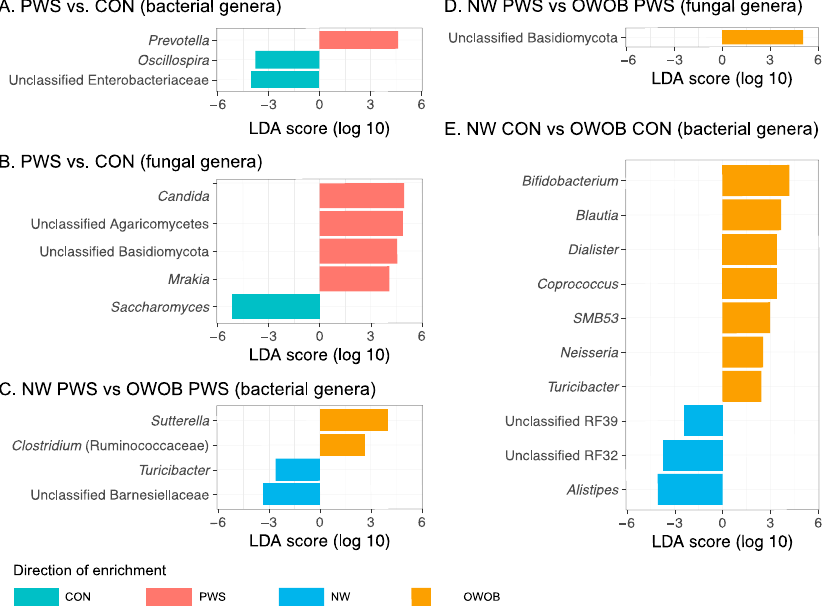
Figure 2. Discriminative features in the linear discriminant analysis effect size (LEfSe) analysis. ( A ) Discriminative bacterial genera in PWS vs. CON. ( B ) Discriminative fungal genera in PWS vs CON. ( C ) Discriminative bacterial genera in NW PWS vs. OWOB PWS groups. ( D ) Discriminative fungal genera in NW PWS vs. OWOB PWS groups. ( E ) Discriminative bacterial genera in NW CON vs. OWOB CON groups. PWS: Prader–Willi syndrome; CON: control. NW: normal weight; OWOB: overweight or obese.